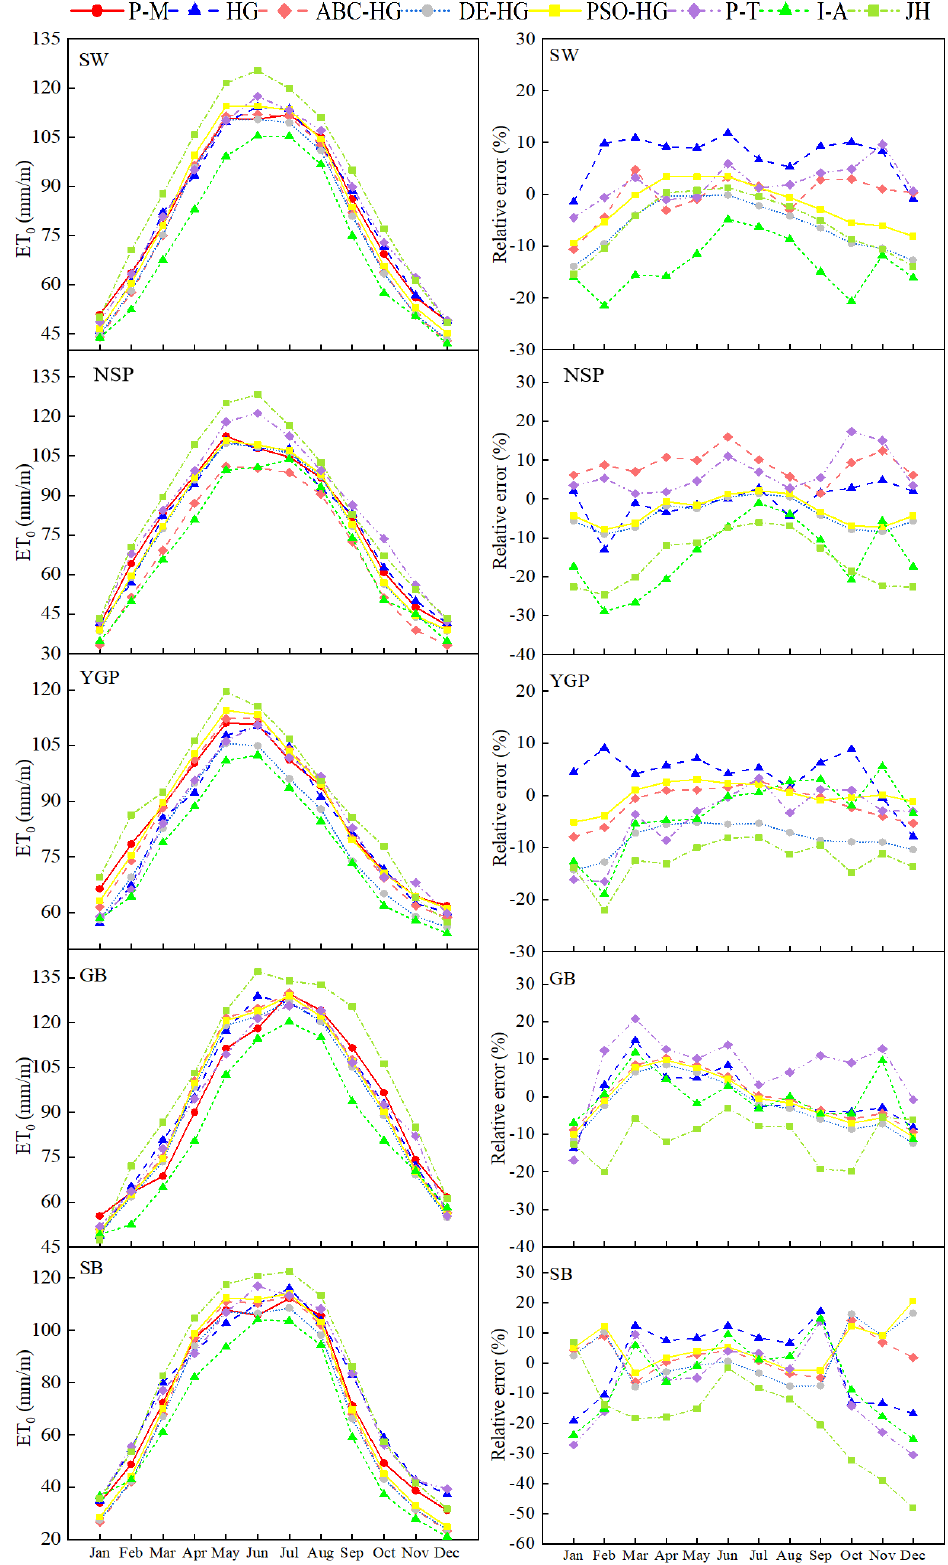
Figure 5. Comparison of the accuracy of the monthly average evapotranspiration estimation model in the southwest and the 4 sub-regions.